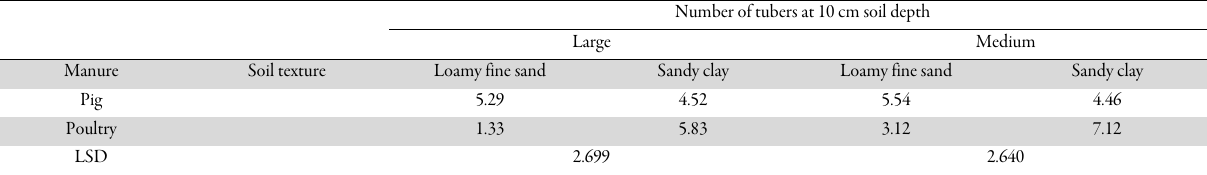
Table 7. Interaction between manure type and soil texture on number of large and medium sized tubers of tiger nut at 10 cm depth